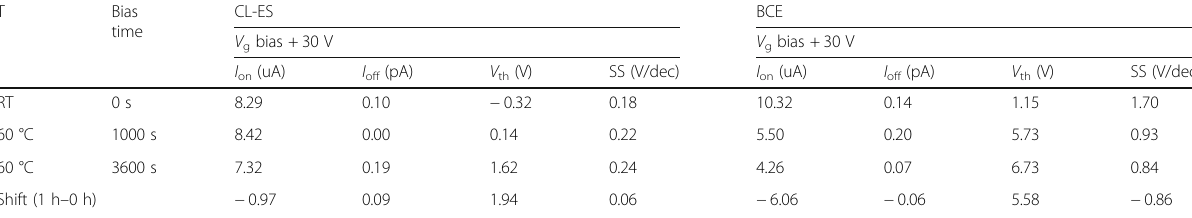
Table 3 PBTS testing results of CL-ES-structured device and BCE-structured